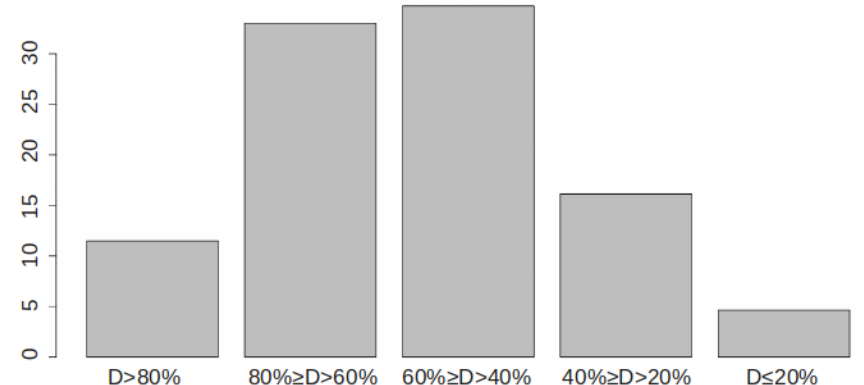
Figure 2. Histogram of the number of ICOs per percentage of Token to be sold during the ICO.